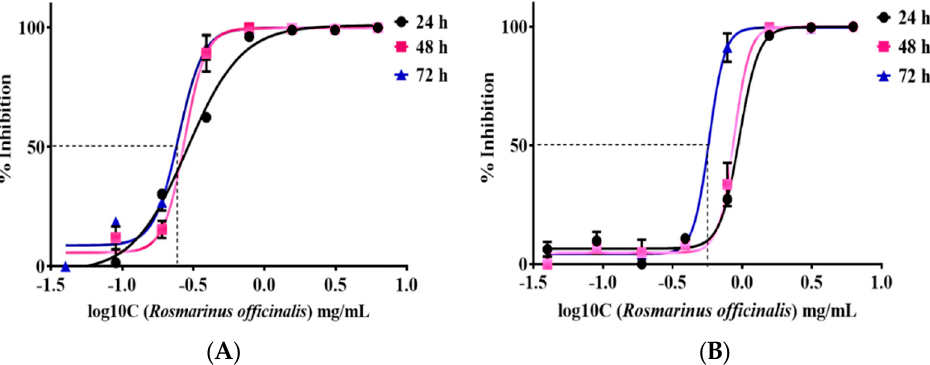
Figure 2. IC 50 of R. officinalis extract on TE671 cells ( A ) and A172 cells at 24, 48 and 72 h ( B ). The lowest IC 50 value for TE671 cell line was 0.249 ± 1.09 mg/mL, calculated at 72 h and 0.577 ± 0.98 mg/mL for A172 cell line, calculated at 72 h. Cancer -cell viability increases as concentration of the drug decreases.